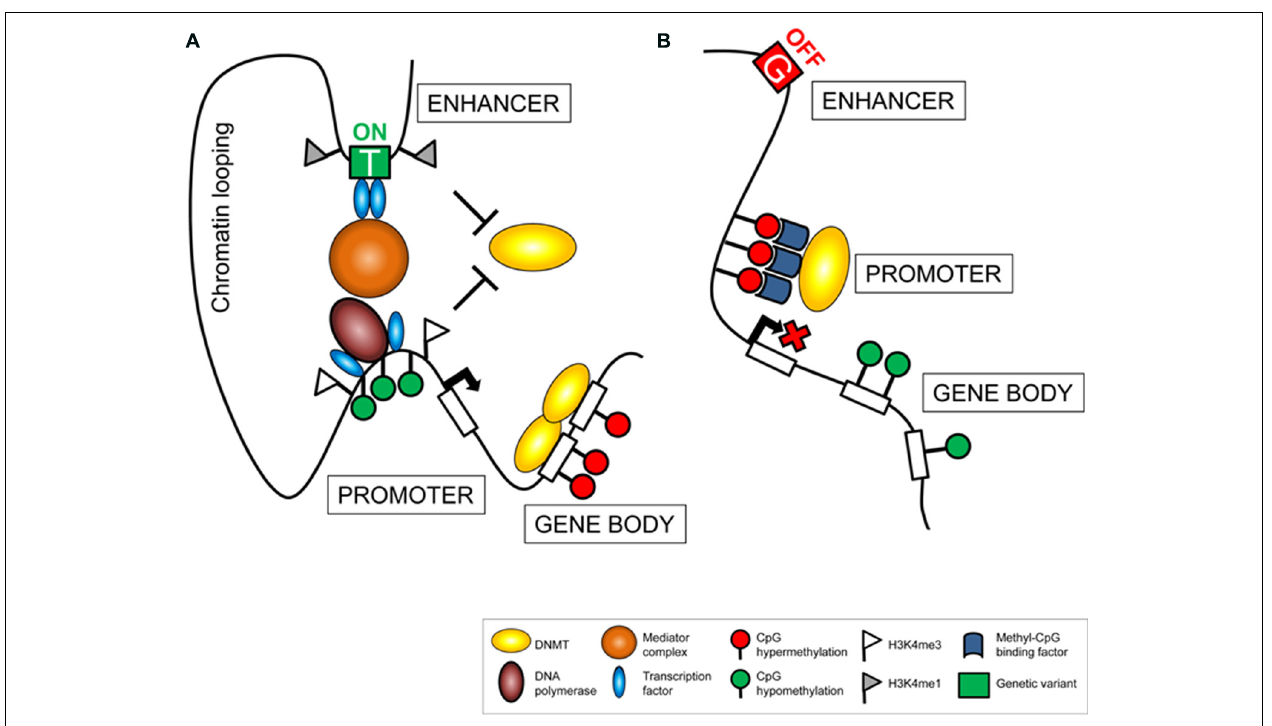
FIGURE 1 | Genetic variance affects the regulatory machinery. Polymorphic alleles located in cis -regulating elements (e.g., enhancer sites) can be associated to variation in downstream cascades resulting in transcriptional activation (A) or silencing (B) . Changes in gene regulation